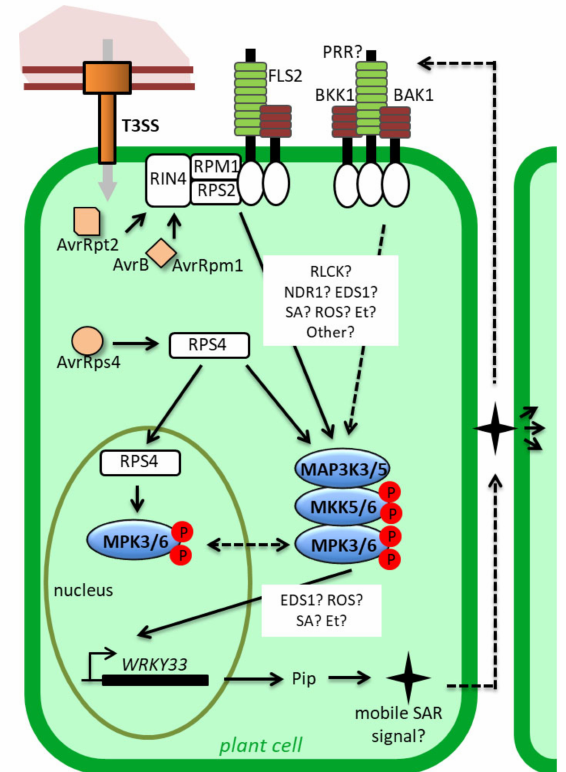
Figure 3. Representation of the demonstrated and putative mechanisms triggering and regulating sustained MPK3 / 6 activities in ETI. MPK3 / 6 are activated upon recognition of the e ff ectors AvrRpt2, AvrB and AvrRpm1 by the CNLs RPS2 and RPM1 in the plasma